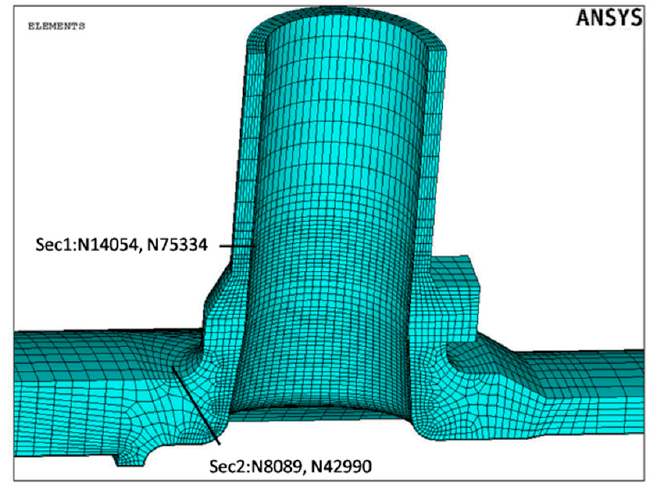
Figure 4. Finite element model and target cross-sections of RPV inlet nozzle. According to the operation transients of the RPV in nuclear power plant, the op- transient power variation, 37 design transients are divided into a corresponding 14